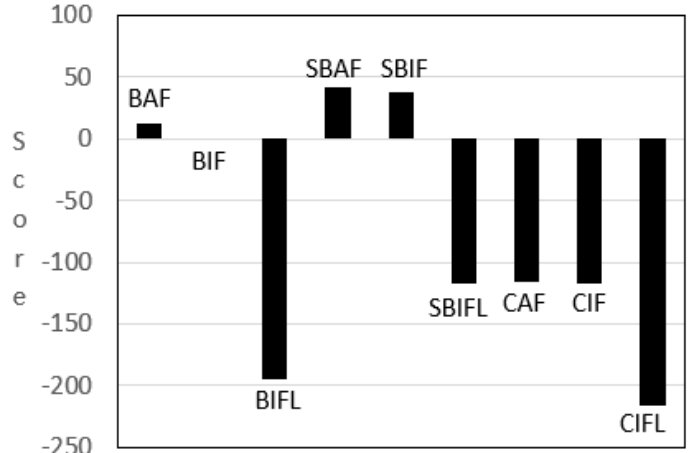
Figure 5. Global scores of the nine designs relative to the BIF design.